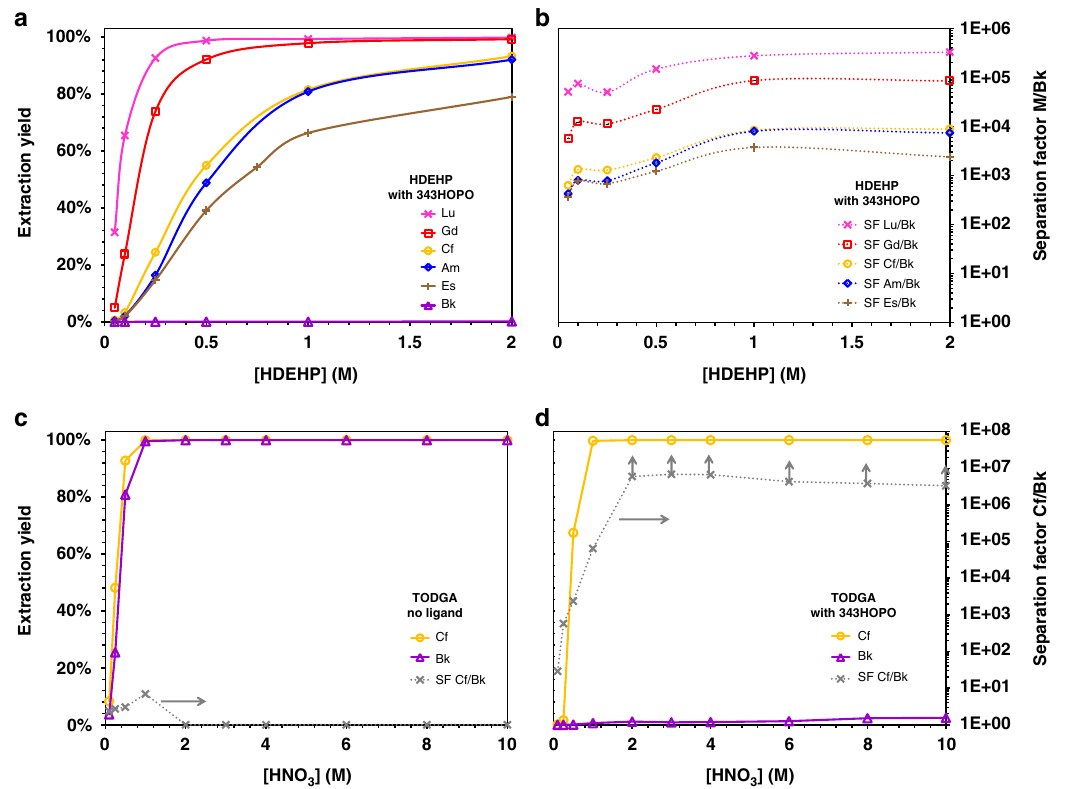
Fig. 5 Separation of Bk, from Gd, Lu, Am, Cf, and Es. a Extraction of 177 Lu (crosses), 153 Gd (squares), 243 Am (diamonds), 249 Bk (triangles), 249 Cf (circles) and 253 Es (vertical crosses) by HDEHP as a function of the extractant concentration. Aqueous phase: 1 mM 343HOPO in 0.1 M HNO 3 and 1.9 M NaNO 3 . Organic phase: HDEHP in kerosene. b Corresponding separation factors. A log scale is used for clarity. See Supplementary Fig. 8 for results as a function of the phase ratio. c and d show the extraction yields of 249 Bk and 249 Cf by TODGA (solid lines) and separation factors Cf/Bk (dotted lines) as a function of the acidity and in the absence or presence of 1 mM 343HOPO, respectively. Aqueous phase: 0 or 1 mM 343HOPO in HNO 3 . Organic phase: 0.1 M TODGA in kerosene. T = 25 °C. O/A = 1, one contact. Points with arrows are lower limits